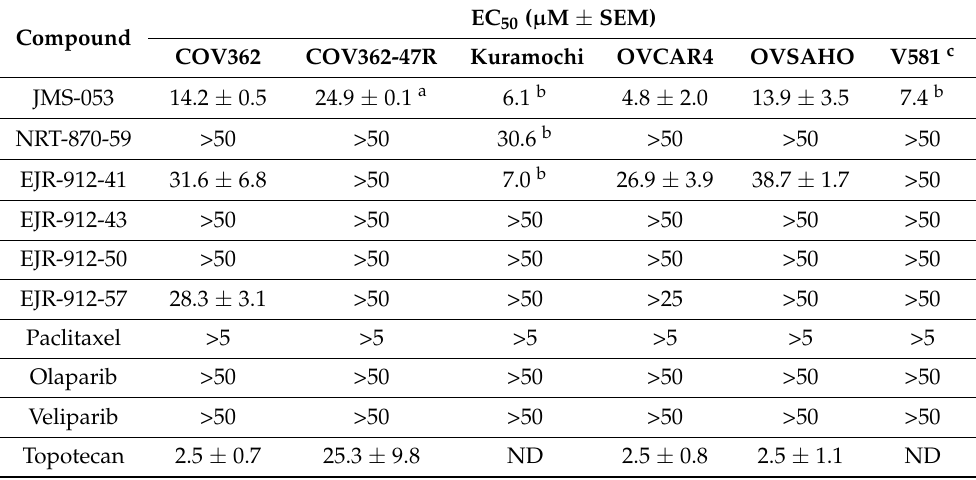
Table 1. Cytotoxicity of compounds against HGSOC cell lines grown in 3D as spheroids. N = 3 biological replicates with 3 technical replicates in each assay. a N = 2 biological replicates ± range with 3 technical replicates in each assay. b N = 1 with 3 technical replicates. c ND = not determined.